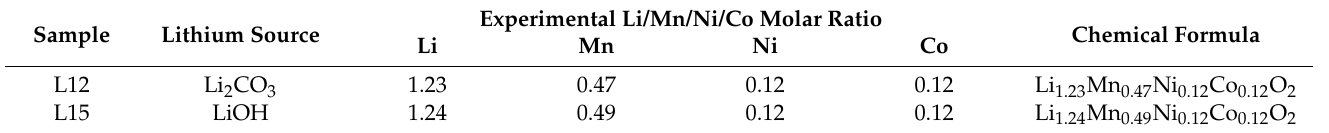
Table 4. Chemical composition of samples L12 and L15 prepared by different lithium sources.